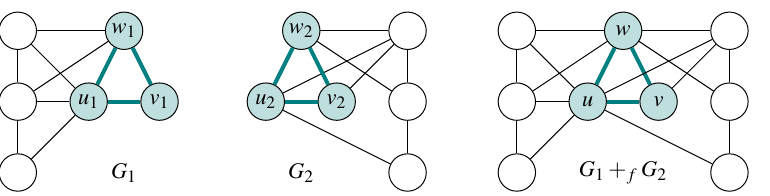
Figure 3. Glued graph from graphs G 1 and G 2 with isomorphism f :